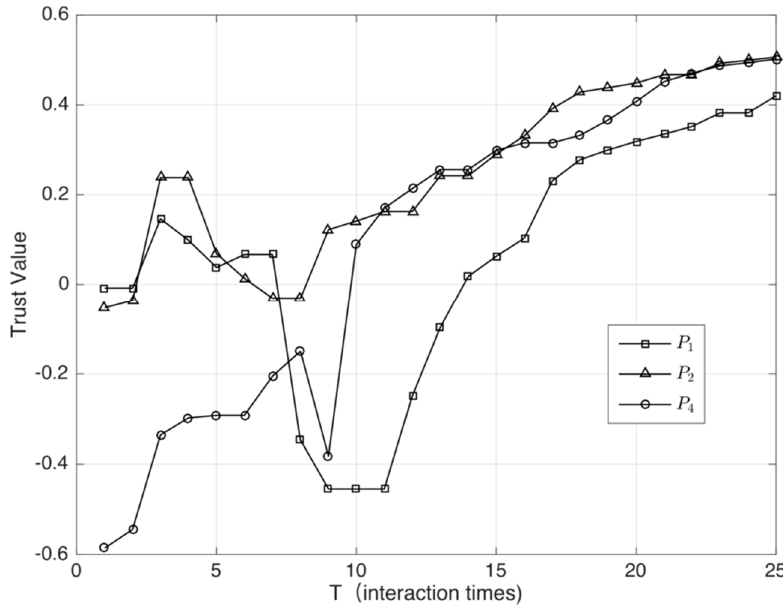
Figure 7. Trust value curve of the benign node under hybrid attacks.